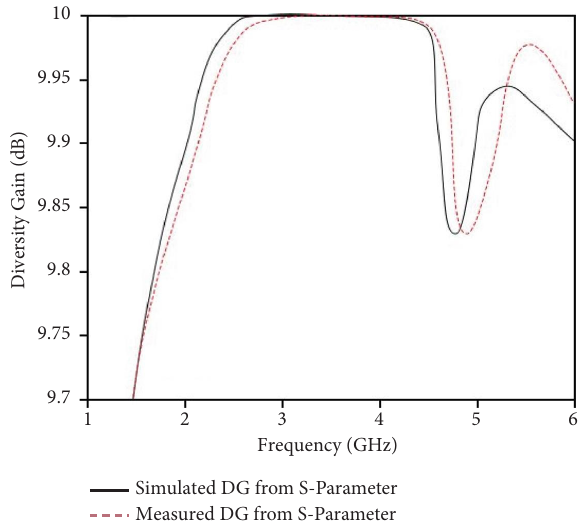
Figure 21: Diversity gain (DG) of the proposed four-port MIMO antenna